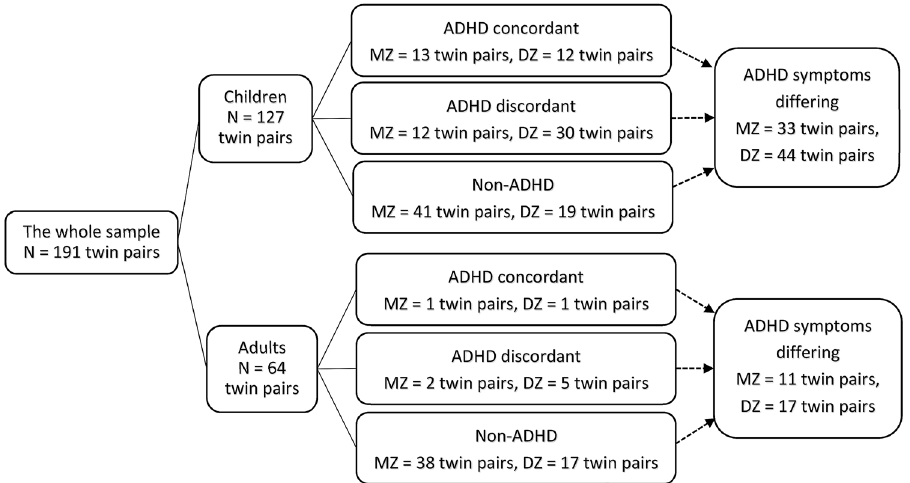
Figure 1. Twin pairs in analyses of the association between somatic comorbidity and clinical (ADHD) and quantitative (ADHD symptoms) ADHD phenotypes. ADHD attention-deficit/hyperactivity disorder, MZ monozygotic twins, DZ dizygotic